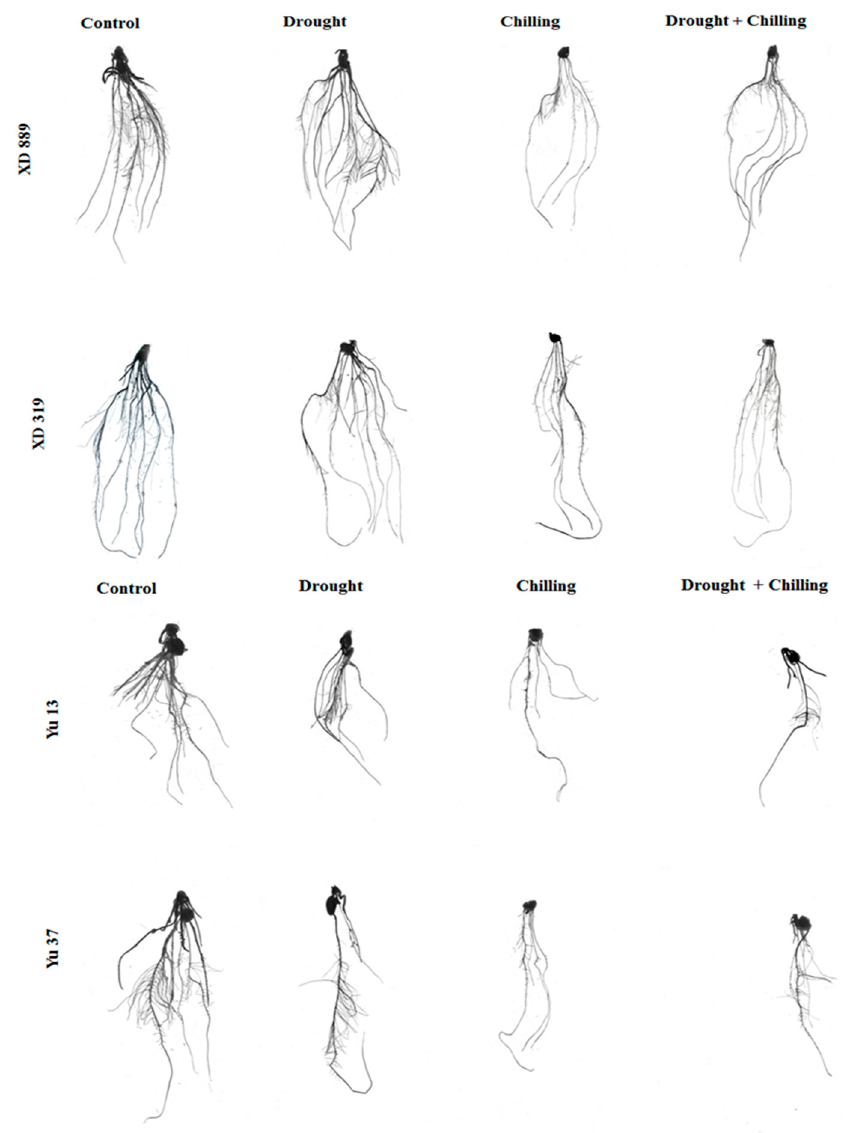
Figure 5. Root growth of maize seedlings (cv. XD889, XD319, Yu13, Yu37) under drought, chilling, and drought + chilling stress conditions.